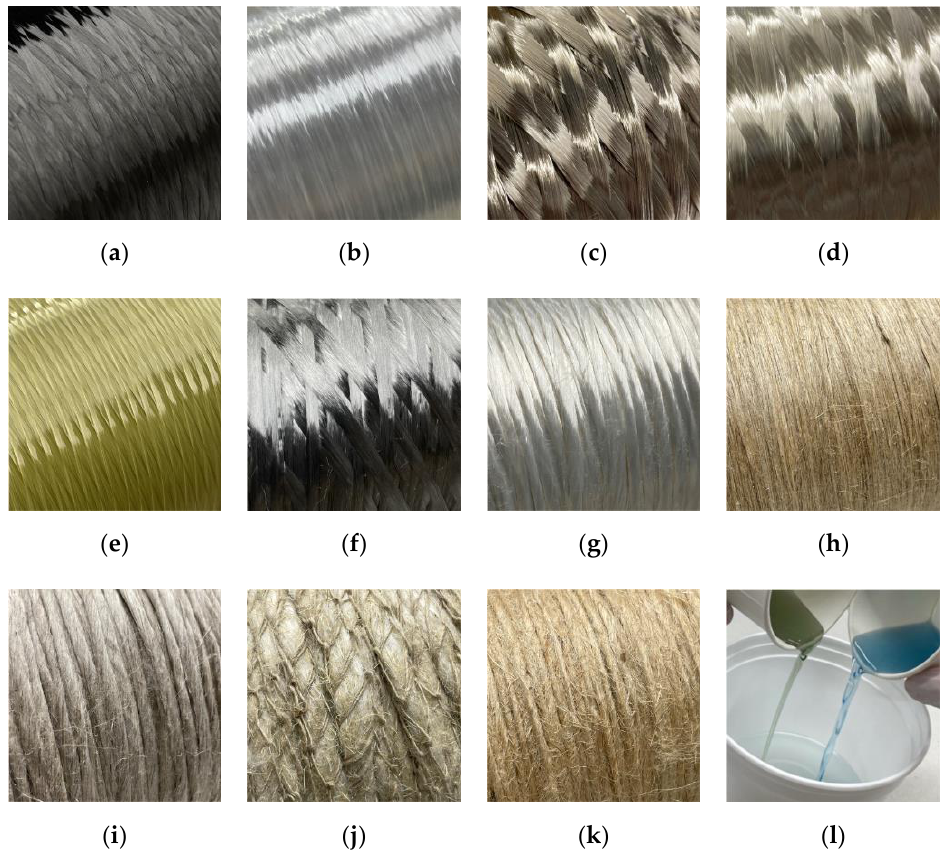
Figure 2. Material selection for this study: ( a ) carbon; ( b ) glass; ( c ) basalt type 1; ( d ) basalt type 2; ( e ) aramid; ( f ) stainless steel; ( g ) viscose; ( h ) flax tape; ( i ) flax yarn; ( j ) hemp (crocheted card sliver); ( k ) jute; ( l ) epoxy resin.